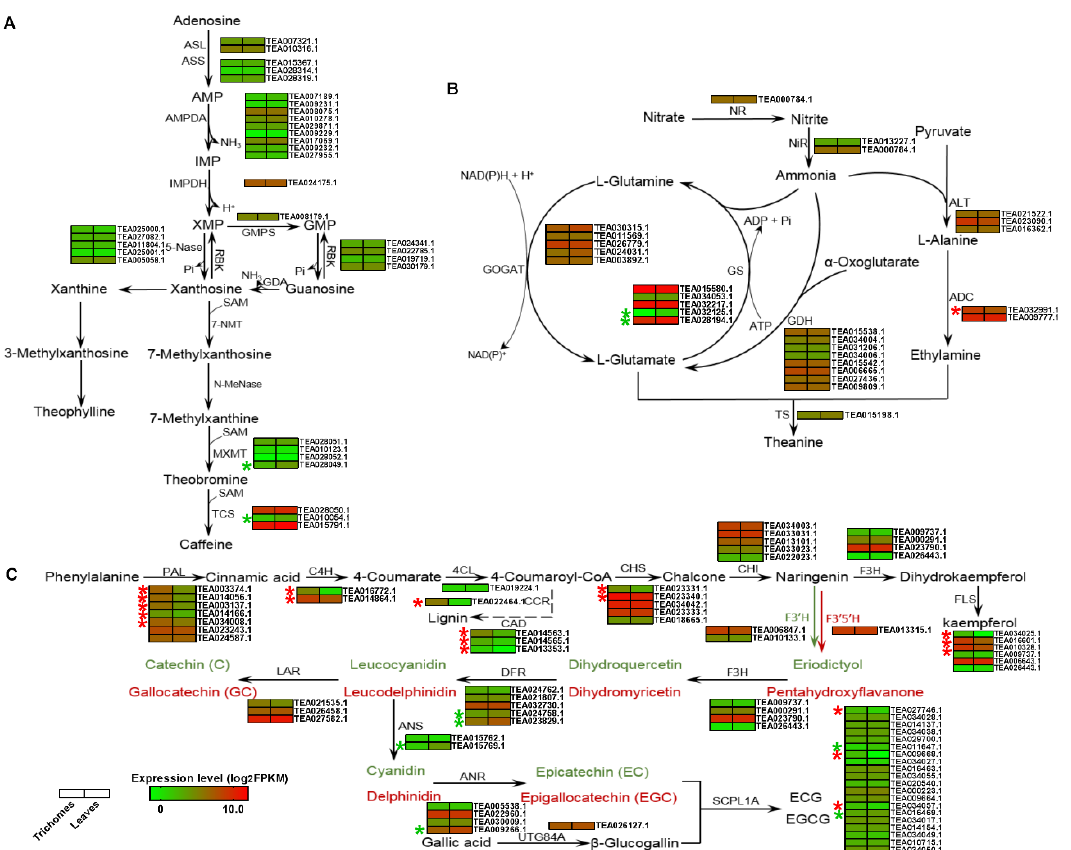
Figure 3. Expression profiles of key genes that are involved in the characteristic metabolite biosynthesis pathways in tea plants. The key genes involved in the caffeine biosynthesis pathway ( A ), theanine biosynthesis pathway ( B ), and catechin biosynthesis pathway ( C ) were identified, and their expression levels in the trichomes and tea leaves are represented by heat maps. The significantly upregulated and downregulated transcripts are shown with red and green asterisks, respectively. ASL, adenylosuccinate lyase; ASS, adenylosuccinate synthetase; AMPD, AMP deaminase; IMPDH, IMP dehydrogenase; GMPS, guanosine monophosphate synthase; RBK, ribokinase; 5′ - Nase, 5′ - nucleotidase; 7-NMT, 7-methylxanthosine synthase; N -MeNase, N-methylnucleotidase; MXMT, theobromine synthase; TCS, tea caffeine synthase; NR, nitrate reductase; NiR, nitrite reductase; GS, glutamine synthetase; GOGAT, glutamate synthase; GDH, glutamate dehydrogenase; ALT, alanine aminotransferase; ADC, argininedecarboxylase; TS, theanine synthetase; PAL, phenylalanine ammonia-lyase; C4H, cinnamic acid 4-hydroxylase; 4CL, 4-coumarate-CoAligase; CCR, cinnamoyl-CoA reductase; CAD, cinnamyl-alcohol dehydrogenase; CHS, chalcone synthase; CHI, chalcone isomerase; F3H, flavanone 3-hyd roxylase; F3′H, flavonoid 3′ - hydroxylase; F3′,5′H, flavonoid 3′,5′ - hydroxylase; FLS, flavonol synthase; DFR, dihydroflavonol 4-reductase; ANS, anthocyanidin synthase; ANR, anthocyanidin reductase; LAR, leucocyanidin reductase; UTG84A, UDP-glycosyltransferase 84A; SCPL1A, serine carboxypeptidase-like 1A. The genes’ fragments per kilobase of transcript per million mapped reads (FPKM) values were listed in the supplementary material Table S3.